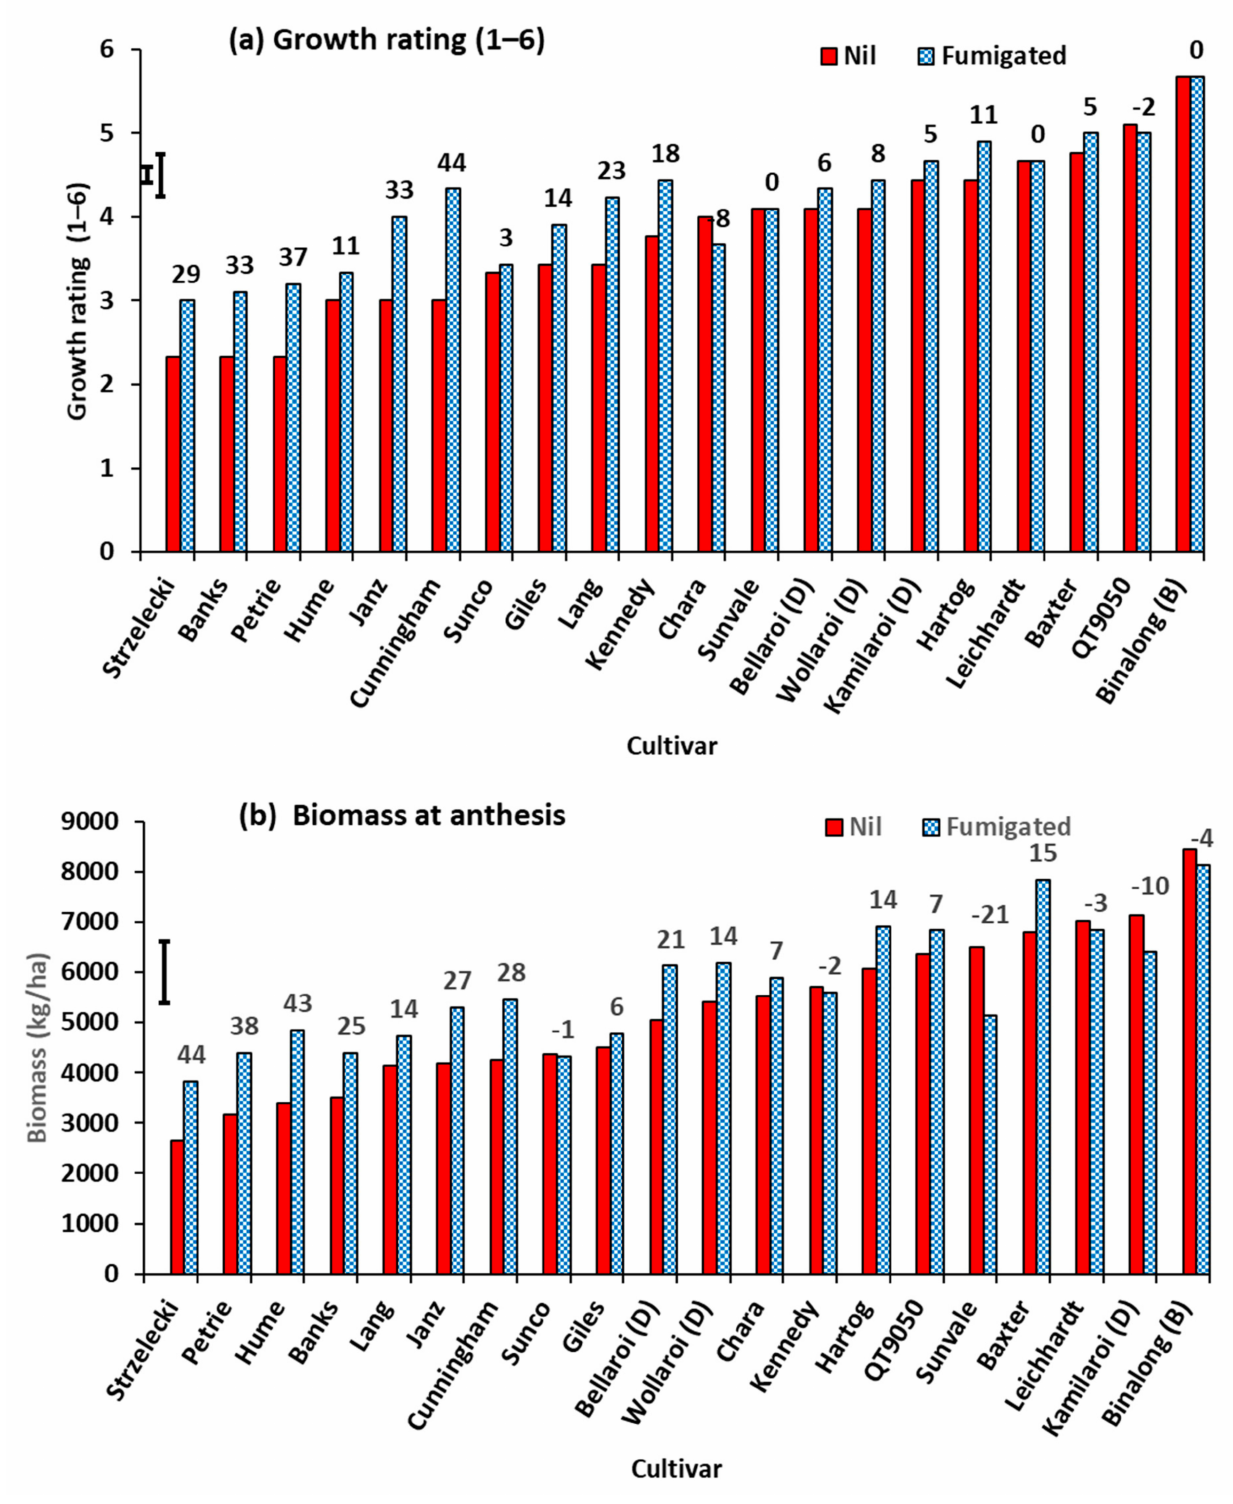
Figure 14. Response of wheat, durum (D) and barley (B) cultivars to soil fumigation with methyl bromide ( a ) growth rating at stem elongation and ( b ) biomass at anthesis. Each graph is presented with cultivars in ascending order of values for nil treatment. Bar markers represent the l.s.d. for ( a ) main effects for fumigation and cultivar, and ( b ) fumigation x cultivar interaction from ANOVA. Values above bars are percentage response to